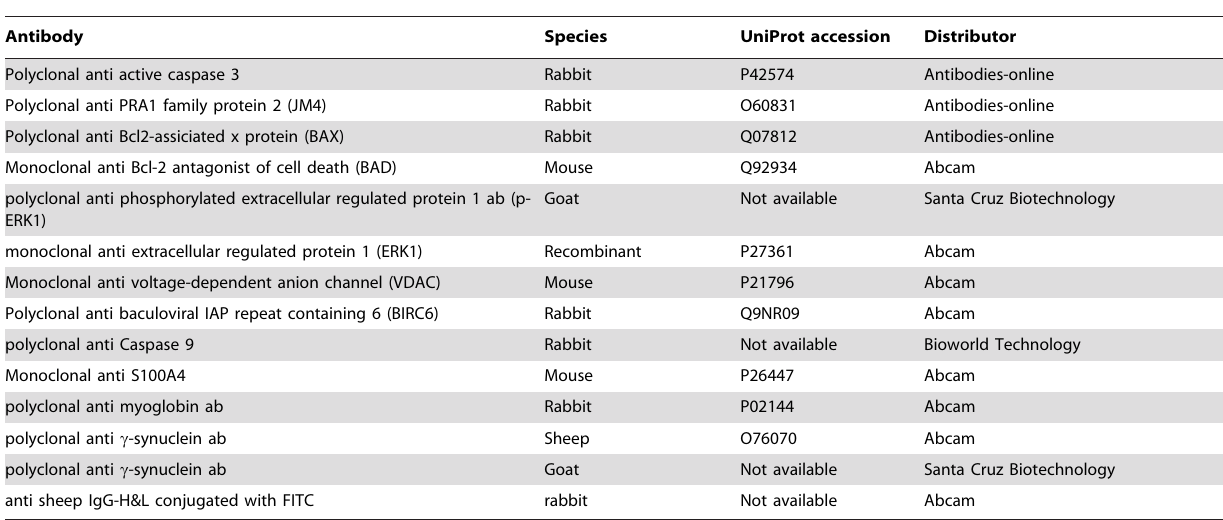
Table 1. List of used abs.